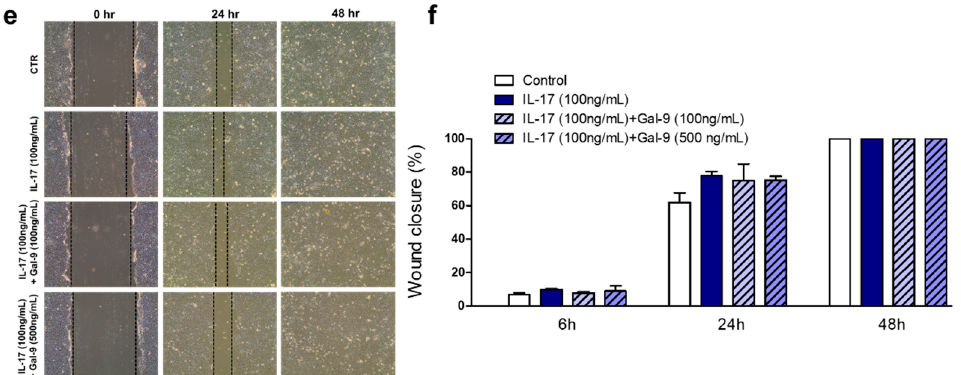
Figure 7. Scratch assay: assessment of HaCaT migration rate after cytokine stimulation and Gal-9 treatment. Human keratinocytes were submitted to the following experimental conditions: control (growth media), stimulated with TNF- α /IFN- γ (10 ng/mL), IL-4 (100 ng/mL), or IL-17 (100 ng/mL), and after 15 min they received human recombinant Gal-9 at 100 or 500 ng/mL or media. Wound assays were observed after 6, 24, and 48 h. Cells were seeded in complete media. Representative photomicrographs show no effect of Gal-9 treatment on keratinocytes under TNF- α /IFN- γ ( a , b ), IL-4 ( c , d ), or IL-17 ( e , f ) stimulation compared to nontreated conditions ( n = 3/group in 2 independent experiments). Data are presented as the mean ± SEM of wound closure (%). * p < 0.05; ** p < 0.01; *** p < 0.001 vs. control at the corresponding time point (ANOVA, Bonferroni